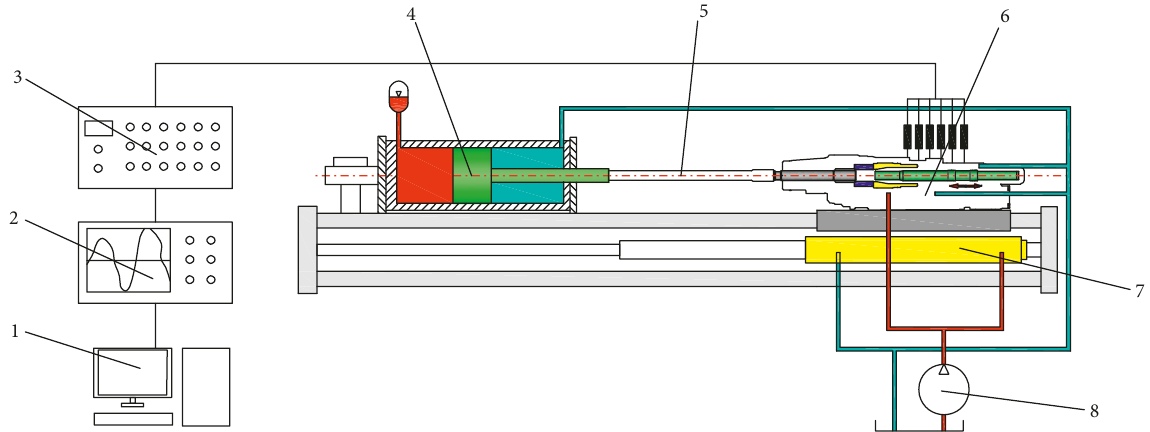
Figure 8: Impact and reversing mechanism principle. 1: computer; 2: data acquisition system; 3: signal amplifier; 4: accepting-impact cylinder; 5: drill rod; 6: hydraulic rock drill; 7: propulsion cylinder; 8: hydraulic pumping